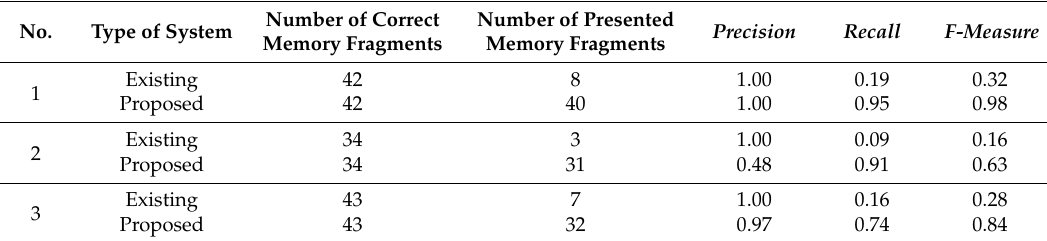
Table 7. Results of the calculation precision, recall, and